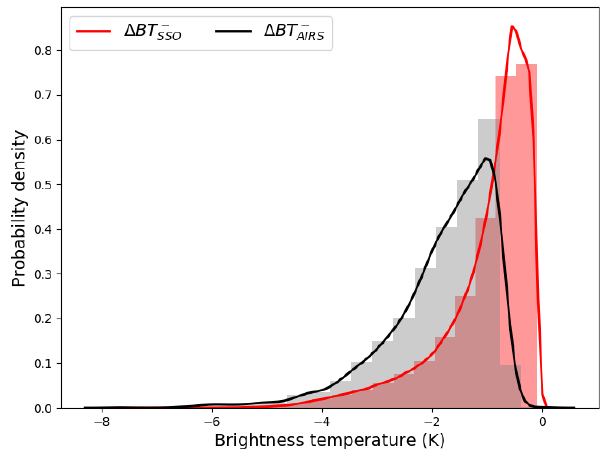
Figure 3. Comparison of the probability distribution of the tem- Figure 2. Comparison of the probability distribution of bright- perature perturbations (K) due to mountain-wave-induced cooling ness temperature perturbations (K) due to mountain-wave-induced over Rothera Research Station on the Antarctic Peninsula between stratospheric cooling over the Antarctic Peninsula between the pa- the parameterisation scheme (cid:49)T − (red line) and the radiosonde rameterisation scheme (cid:49) BT − (red line) and the AIRS observa- SSO SSO observations (cid:49)T − (black line) for May to October at an altitude tions (cid:49) BT − (black line) for May to October. The AIRS val- RS AIRS of around 20.4km. The radiosondes are launched around two to ues are from the 666.5cm − 1 radiance channel, for a 16-year pe- four times a week from Rothera for a 14-year period from 2002 to riod from 2002 to 2017 (and includes some contribution from 2015 (see Fig. 1 for location) and compared against parameterised non-orographic wave sources). The parameterised values are the values from the perturbation run, which are taken from the grid weighted sum of (cid:49)T − from the perturbation run over all verti- SSO box that contains this location. Note that a minimum threshold of cal model levels from 15 to 45km (using the AIRS kernel func- T < − 0 . 1K is used to reduce the inclusion of noise and spurious tion for the 666.5cm − 1 radiance channel), which is required to convert (cid:49)T − to (cid:49) BT − . Note that a minimum threshold of SSO SSO BT < − 0 . 1K is used to reduce the inclusion of noise and spuri- ous events. Both the parameterised and AIRS results are computed within the box indicated in Fig. 1.